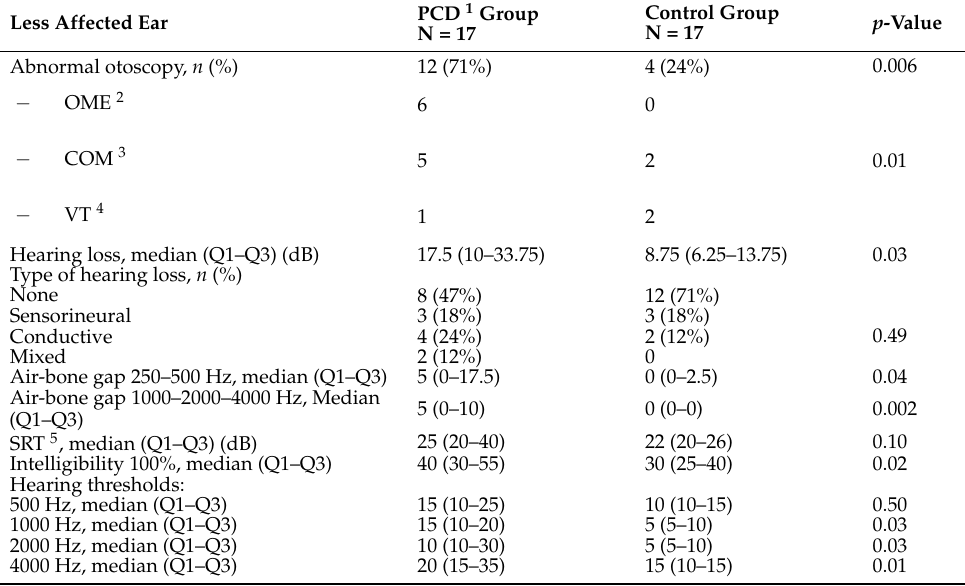
Table 3. Otoscopy and auditory characteristics in patients’ less affected